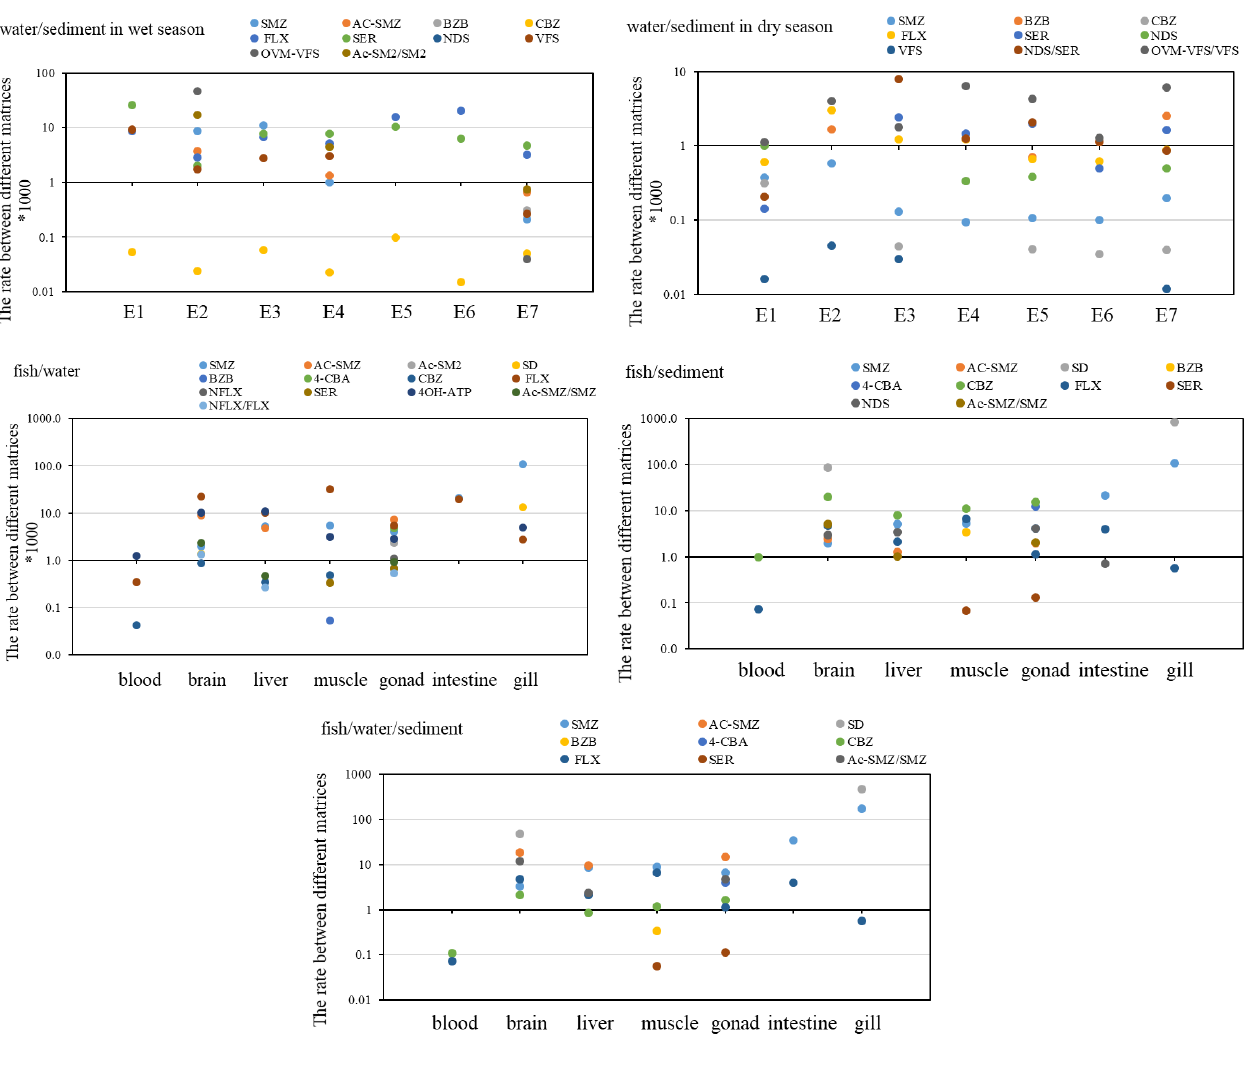
Figure 10. The concentration proportions of different pharmaceuticals between different matrices.